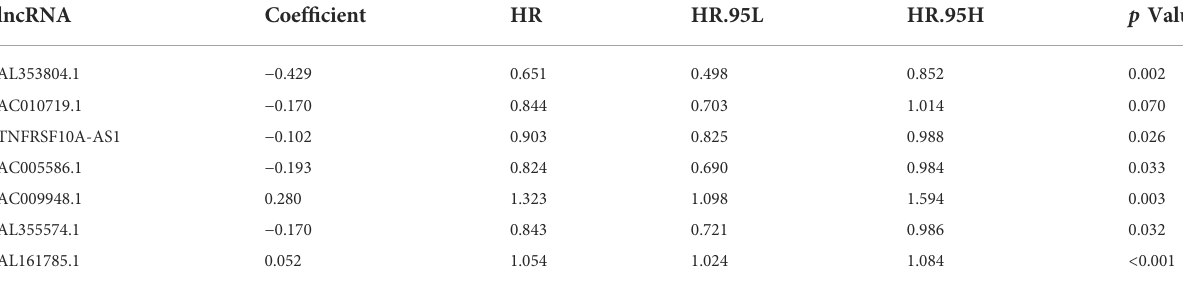
TABLE 1 Multivariate Cox results of glycolysis-related lncRNAs in